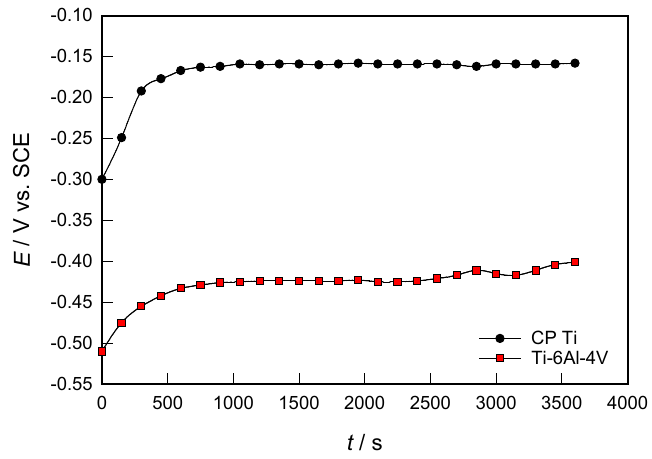
Figure 1. Evolution of open circuit potential over time for investigated samples in PBS solution. The corrosion behaviour of biocompatible materials in PBS solution was investigated by polarization measurements, i.e., by the method of linear polarization to determine polarization resistance ( R p ) and recording potentiodynamic polarization curves in a wide range of potentials for determining corrosion parameters and predicting anodic behavior of Ti (Ti-6V-4Al)/PBS solution systems. The R p data were determined from the slope of linear i - E dependencies recorded in a narrow potential range ± 20 mV vs. E OC (Figure 2) and shown in Table 2.